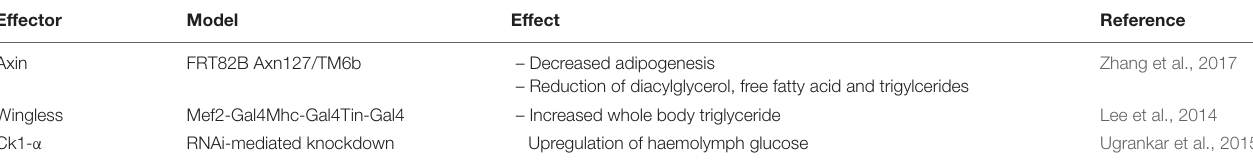
TABLE 5 | Metabolic phenotype resulting from over-expression or deletion of Wnt signaling effectors in